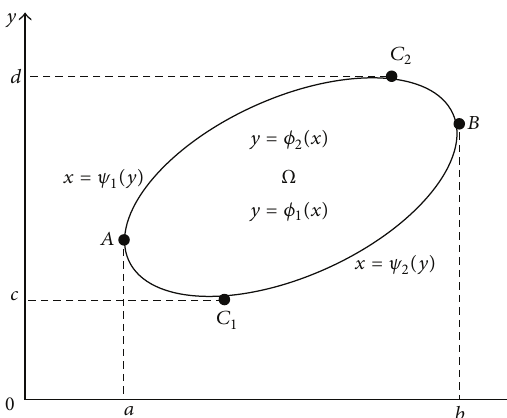
Figure 1: Simply connected space Ω and its smooth boundary curve 𝐶 .